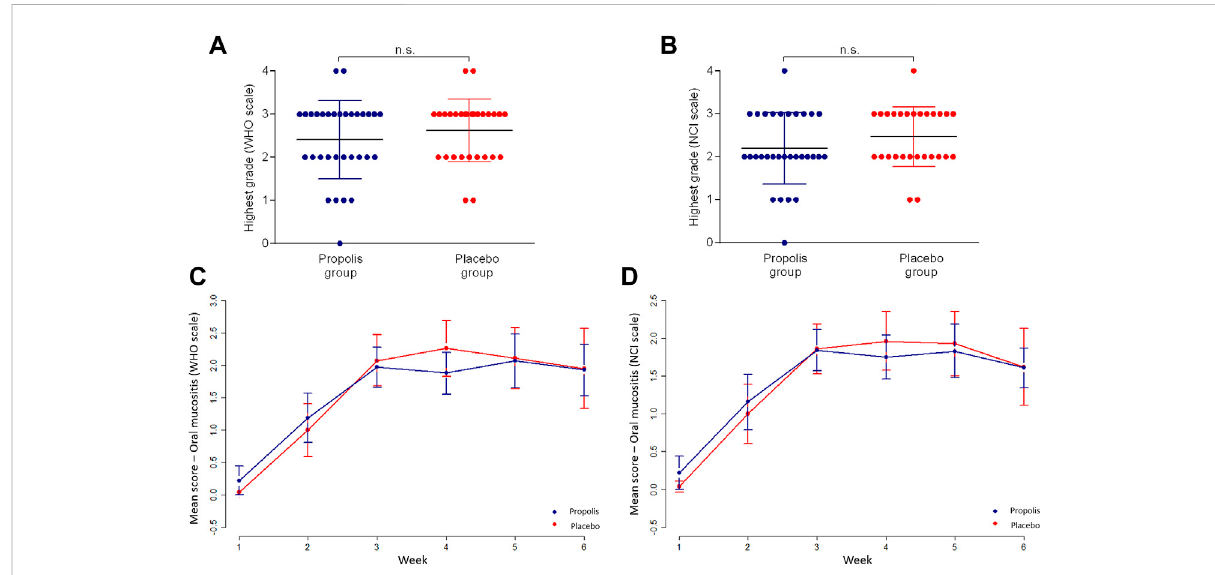
FIGURE 3 The highestgrade oforalmucositis that each patient developed according to WHO (A) and NCI (B) scales. Weeklymean score oforal mucositis according to WHO (C) and NCI (D)